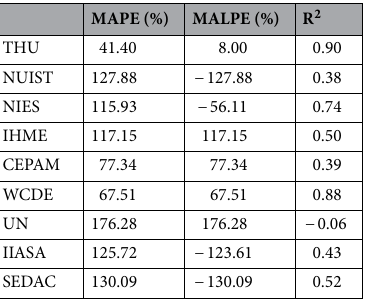
Table 3. Measurements of projection error from 2010 to